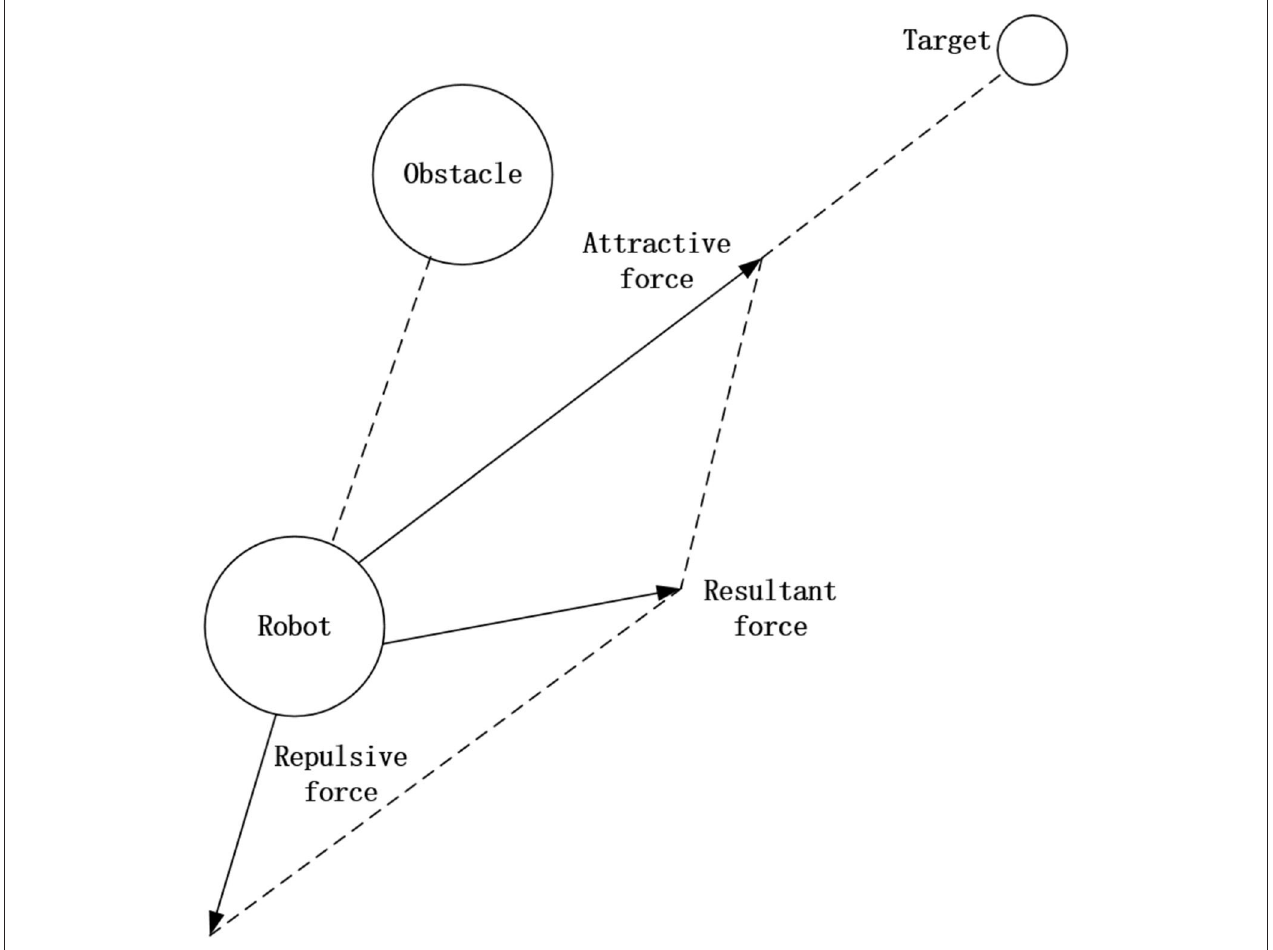
FIGURE 9 | Force analysis diagram of robot in potential